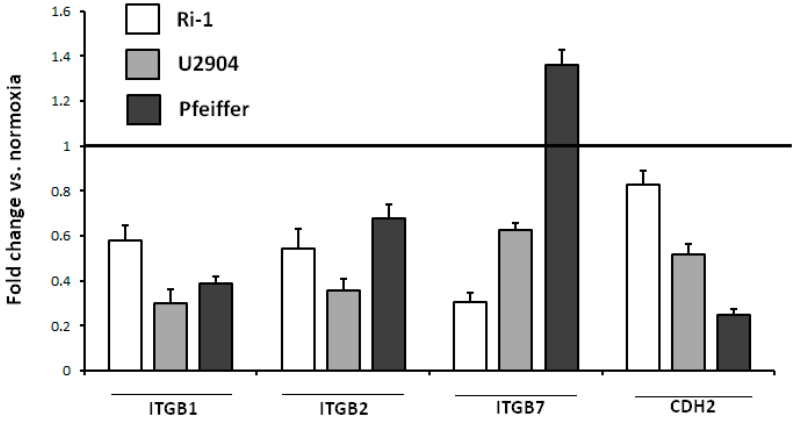
Figure 9. Fold change in cellular adhesion molecules expression for Ri-1, U2904, and Pfeiffer cell lines after incubation of 72 h in physioxia examined by confocal microscopy. Evaluated cellular adhesion molecules (CAMs) are: integrin β 1 (ITGB1), integrin β 2 (ITGB2), integrin β 7 (ITGB7), and cadherin-2